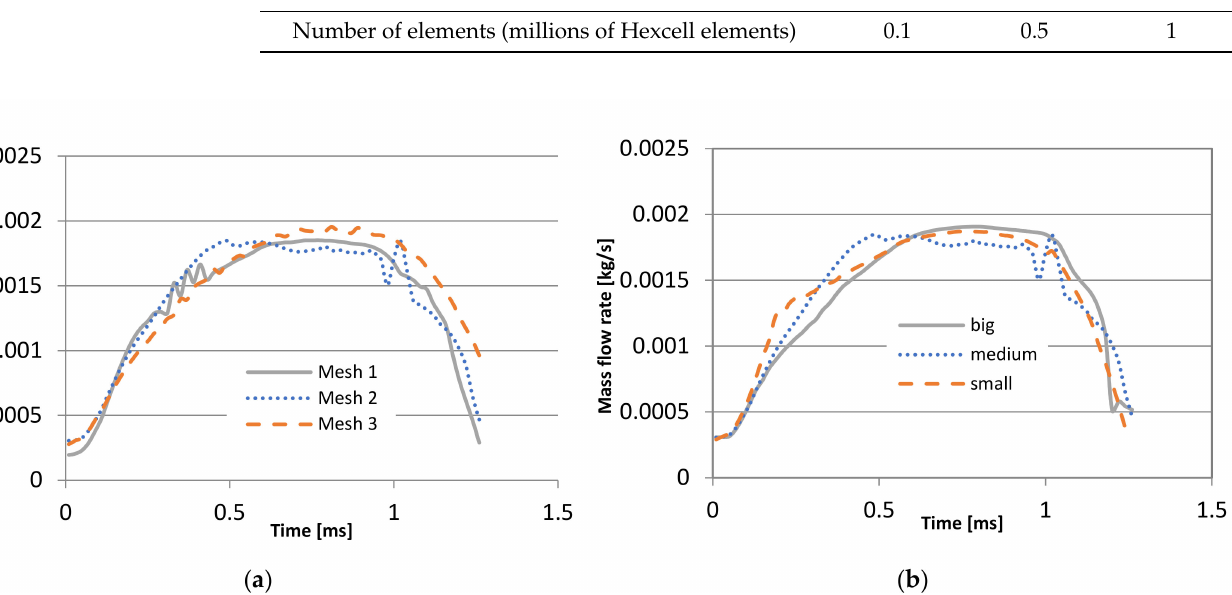
Figure 4. Results of the mesh independence study ( a ) and results of the time independence study ( b ): Evolution of mass flow rate over